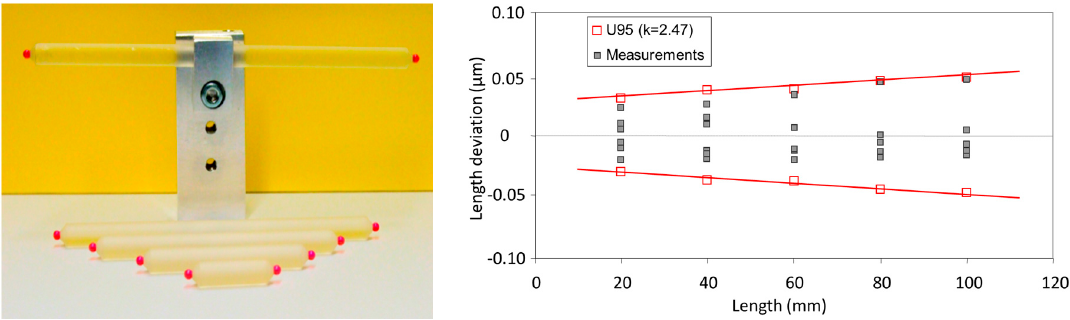
Figure 7. ( left ) Micro ball bars used for performance verification; ( right ) Length deviations measured with 5 different ball bars each oriented in different axial and diagonal directions. Red squares denote the symmetric 95% confidence intervals, red lines the fitted 95% confidence length measurement error E 0 = 27 nm + 0.2 × 10 − 6 × L .